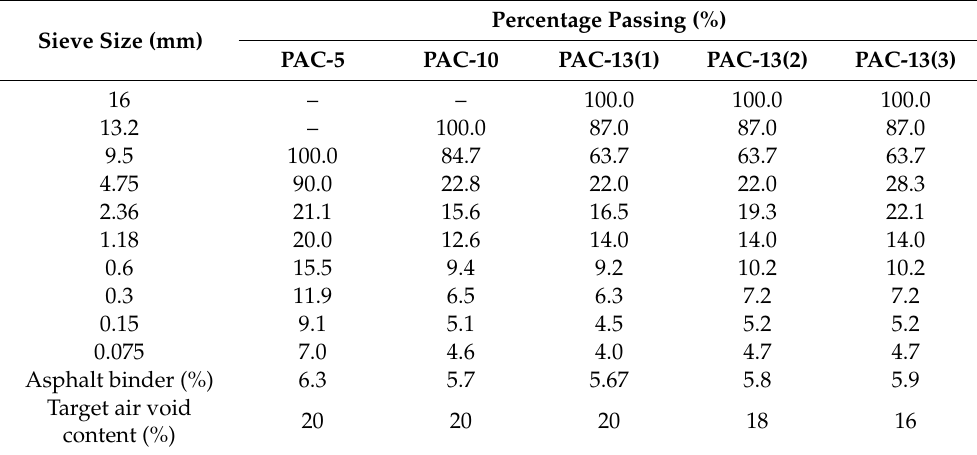
Table 1. Gradations of porous asphalt concrete (PAC) with di ff erent maximum aggregate sizes and air void